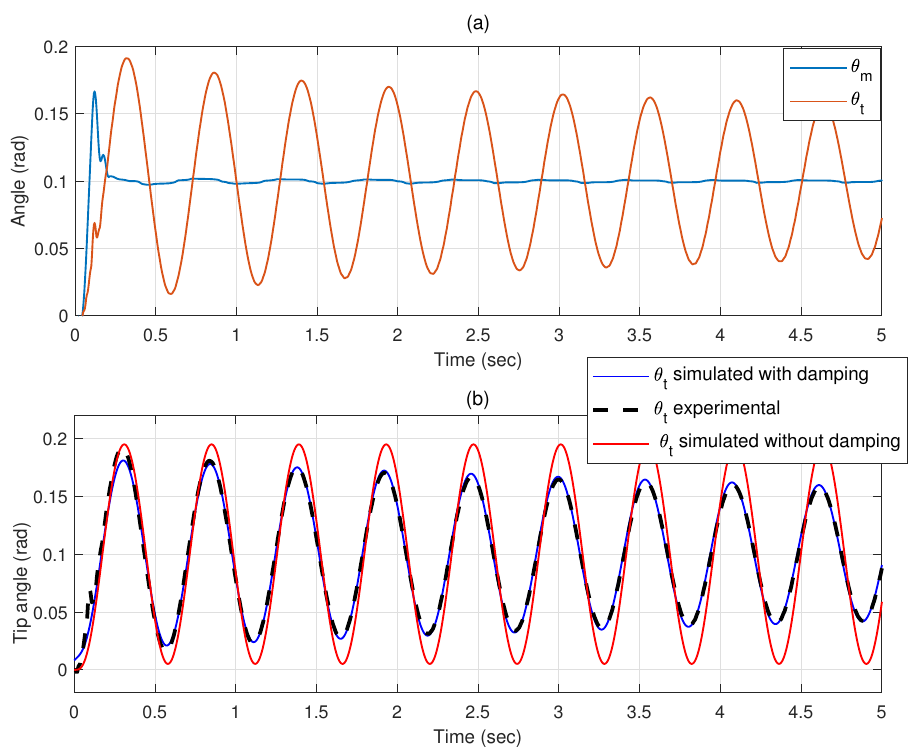
Figure 8. Verification of the model of the link dynamics in the time domain: ( a ) measured motor and tip angles, ( b ) comparison of simulated and real tip angle